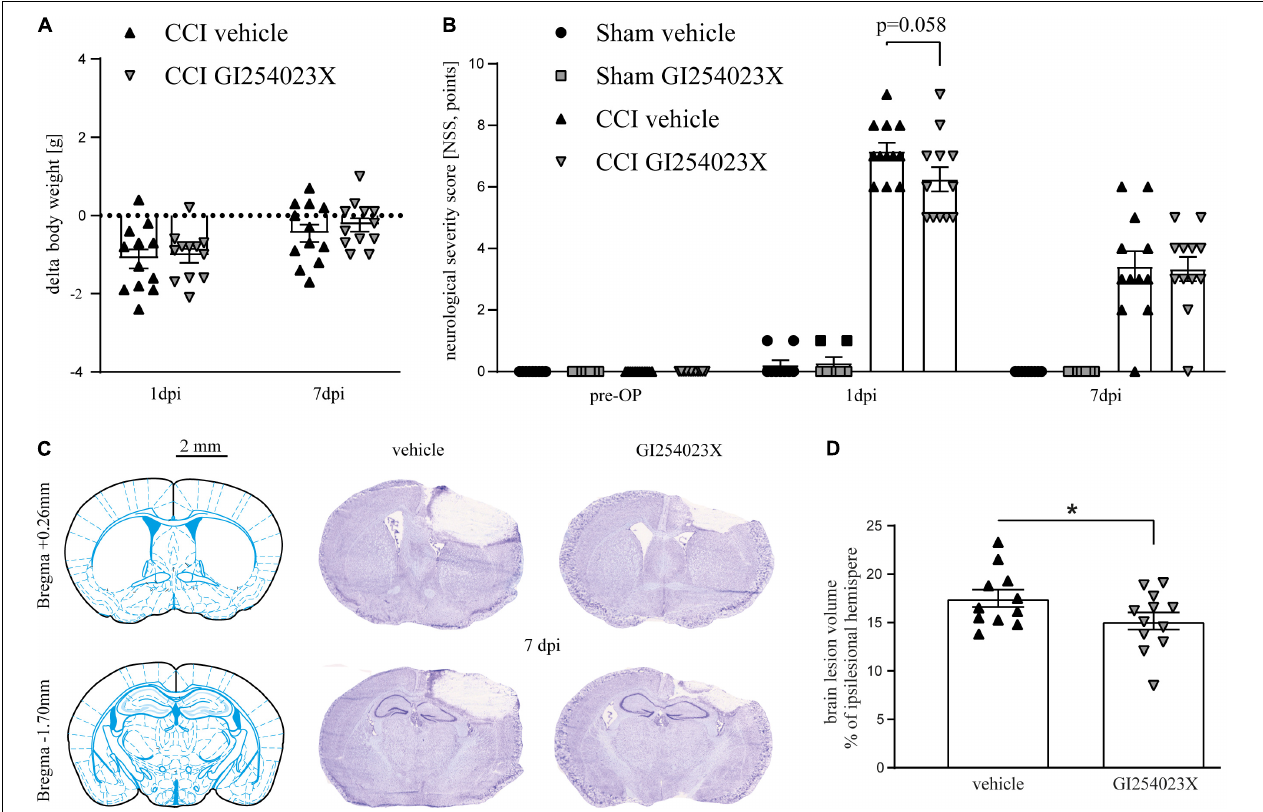
FIGURE 1 | GI254023X does not attenuate neurological deficits but brain tissue loss after TBI. (A) Loss of body weight at 1 and 7 dpi compared to 1 day pre-OP in vehicle- or GI254023X-treated CCI mice. The dotted line refers to the pre-operation body weight. No differences were observed between vehicle and GI254023X treated mice as tested by two-way ANOVA. (B) Evaluation of neurological deficits using a NSS (0 = no impairment, 12 = maximal impairment). Animals were tested at the day before surgery (pre-OP), at 1 and 7 dpi. No differences were observed between vehicle and GI254023X treated mice as tested by Kruskal-Wallis test for each time point. (C) Schemes showing Bregma levels at +0.26 and − 1.7 mm (Franklin and Paxinos Mouse Atlas 3rd edition) and cresyl violet stained coronal brain cryosections. Scale bar: 2 mm. (D) Brain lesion volumetry calculated from 16 consecutive sections at 7 dpi showing smaller lesions in GI254023X compared to vehicle treated mice as tested by Student’s t -test (* p < 0.05). Data are expressed as lesion volume in% of the ipsilesional hemisphere. One outlier was removed after identification by ROUT’s test in (D) . Values from individual animals and mean ± SEM are